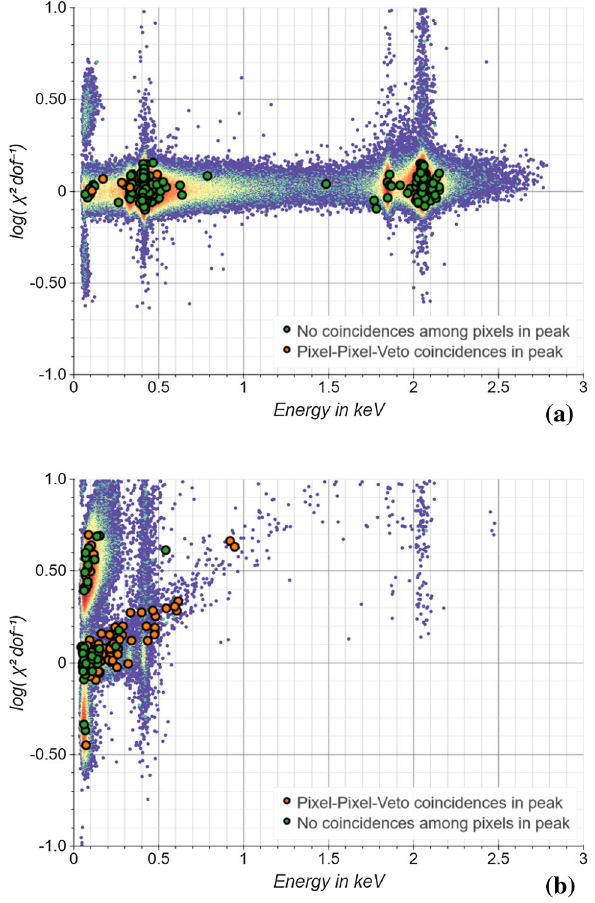
Fig. 14 The reduced χ 2 - E Filter scatter plot. The green dots are events coincidental to the muon veto but not coincidental to other pixel events and the orange dots are Pixel–Pixel–Veto coincidences. Random coin- cidencesbetweenthemuonvetoandpixeleventscanmostlybefoundin data only coincidental to the muon veto and (muon induced) substrate events generate mostly coincidences among pixels. a Events located inside of all three ellipses are shown. The 163 Ho EC events with the M and N lines can be identified. b Events with a value located outside at least of one ellipse